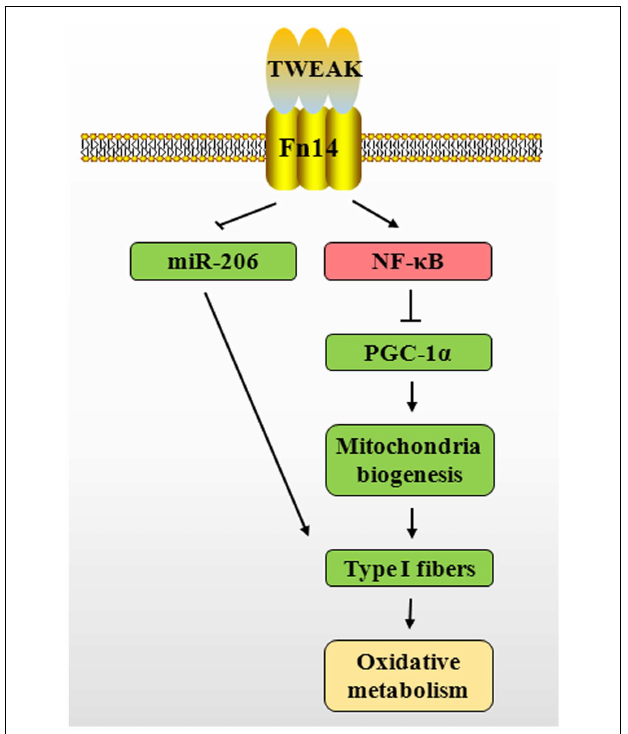
FIGURE 3 | Putative mechanisms by whichTWEAK–Fn14 system inhibits skeletal muscle oxidative phosphorylation capacity . TWEAK/Fn14 system activates canonical NF- κ B signaling pathway, which represses PGC-1 α levels in skeletal muscle.This leads to reduced expression of several mitochondrial genes and proportion of type I fibers. TWEAK also decreases the expression of miR-206, a positive regulator of type I fibers.TWEAK,TNF-like weak inducer of apoptosis; Fn14, fibroblast growth factor inducible 14; NF- κ B, nuclear factor-kappa B; PGC-1 α